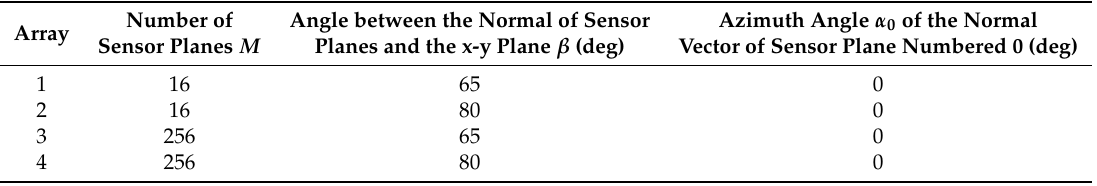
Table 2. Configurations of simulated